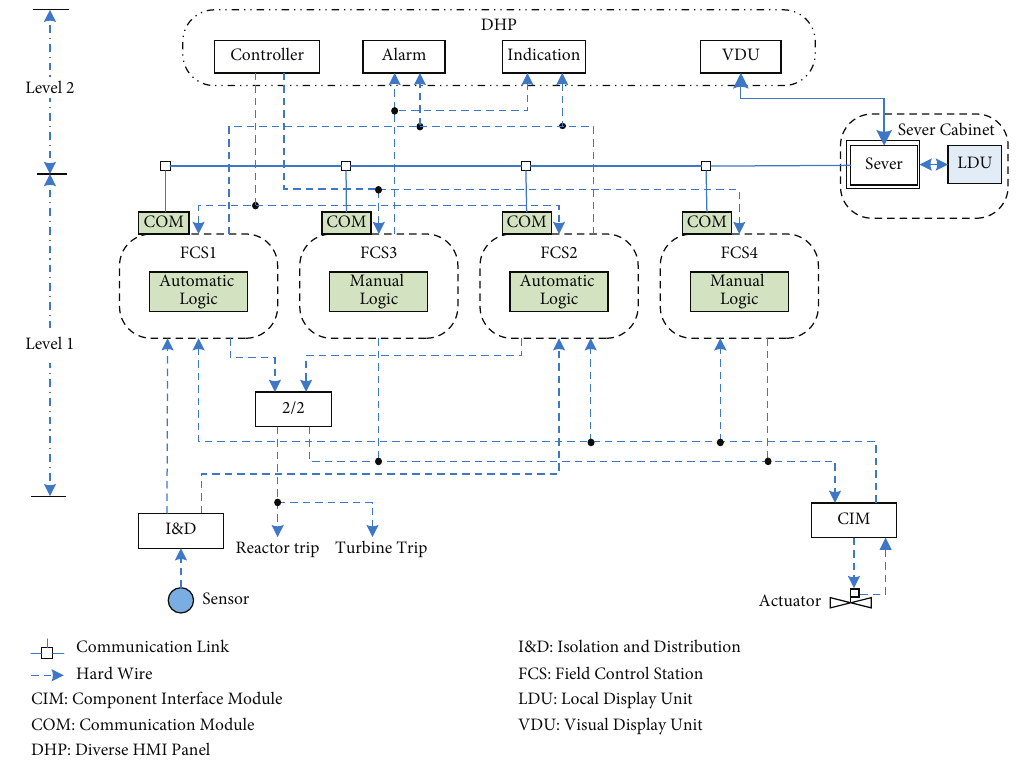
Figure 3: DAS architecture and